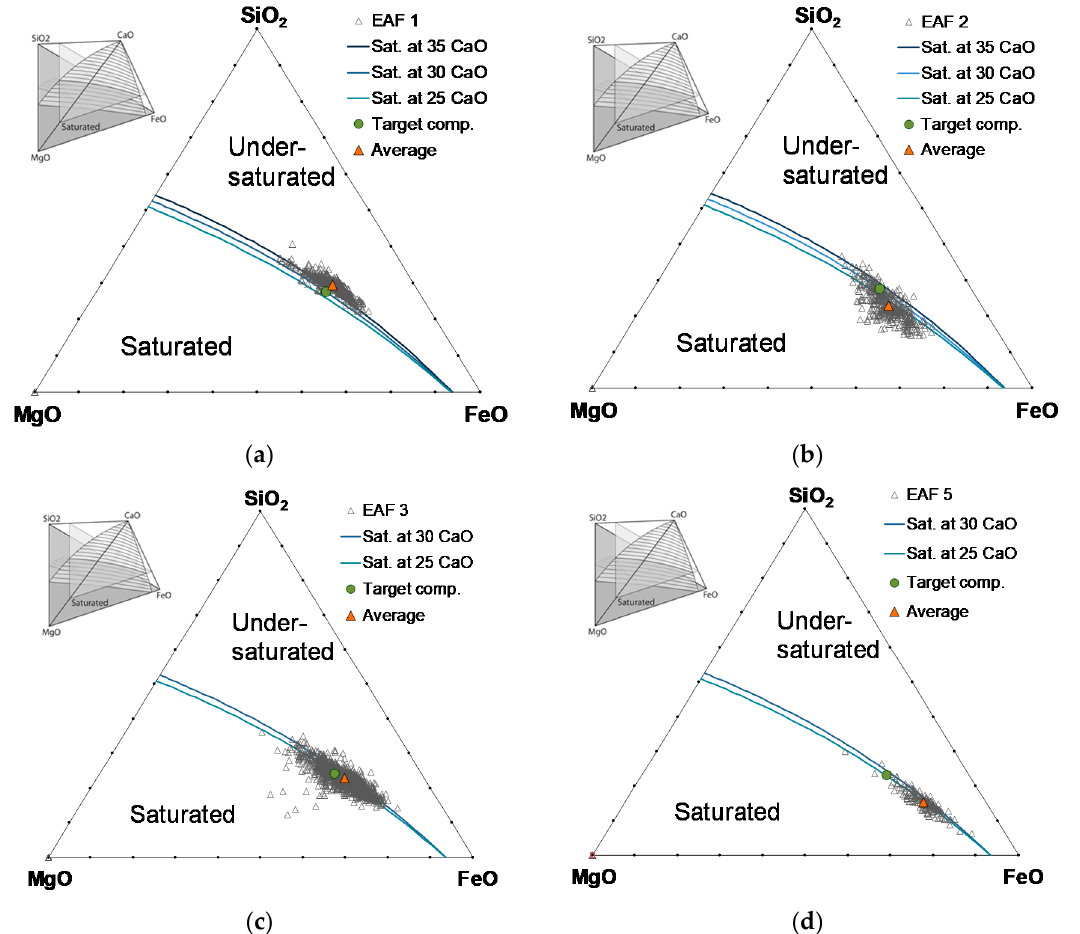
Figure 1. Distribution of slag analysis data from EAF heats for carbon steelmaking based on steel scrap (4 different EAFs ( a – d )), in the system CaO-SiO 2 -FeO-MgO-5% Al 2 O 3 ; lines indicate MgO saturation at 25% to 35% CaO and 1600 ◦ C